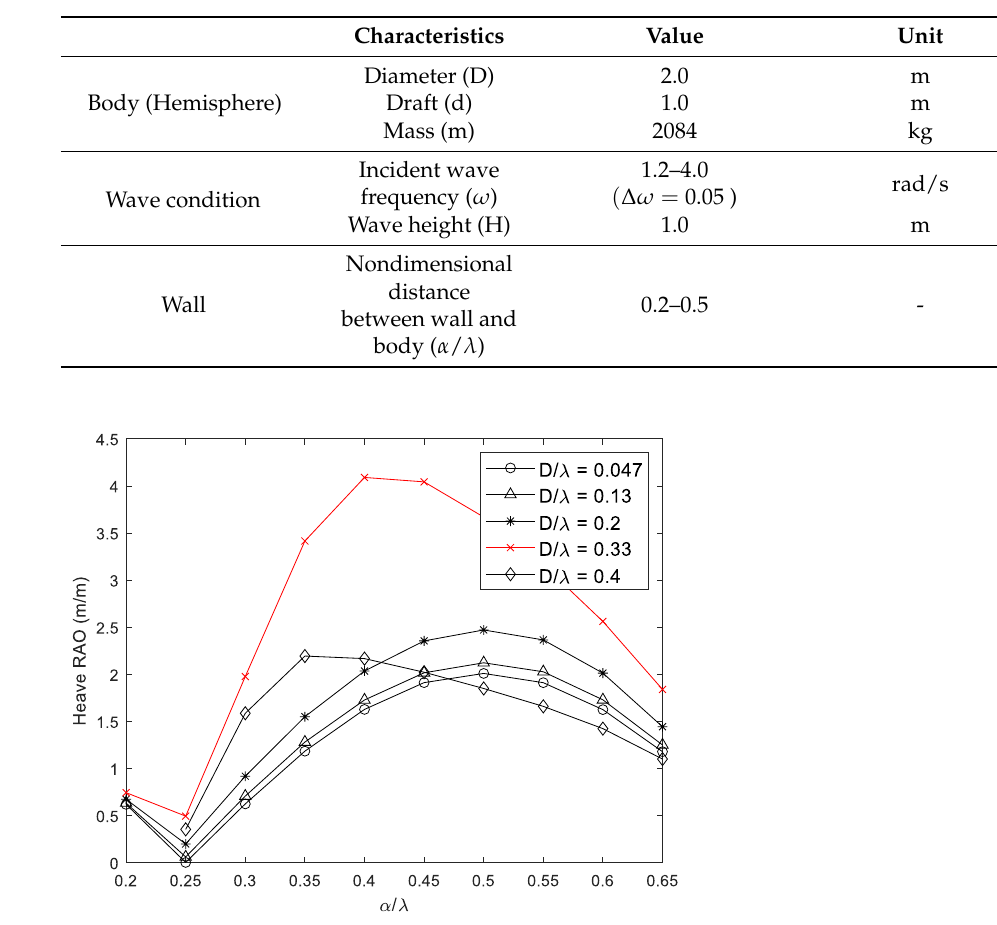
Figure 16. Heave RAOs under various distance conditions between the wall and floater.